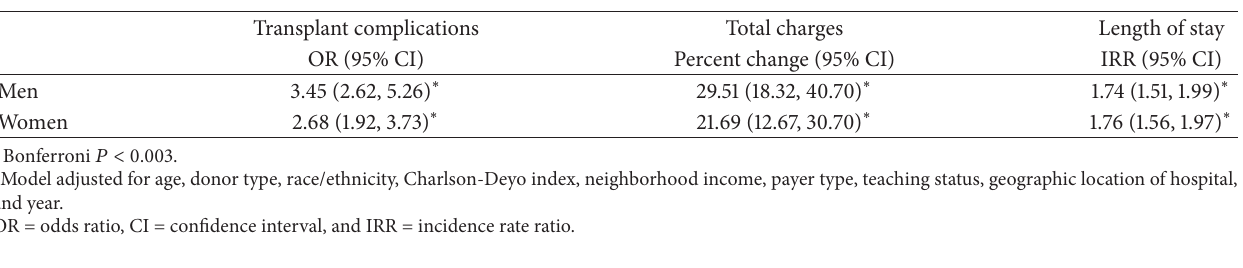
Table 5: Multivariable regression analyses of sensitivity analysis (excluding 65 years or older) on impact of urinary tract infection among renal transplant recipients, NIS 2009–2011 a